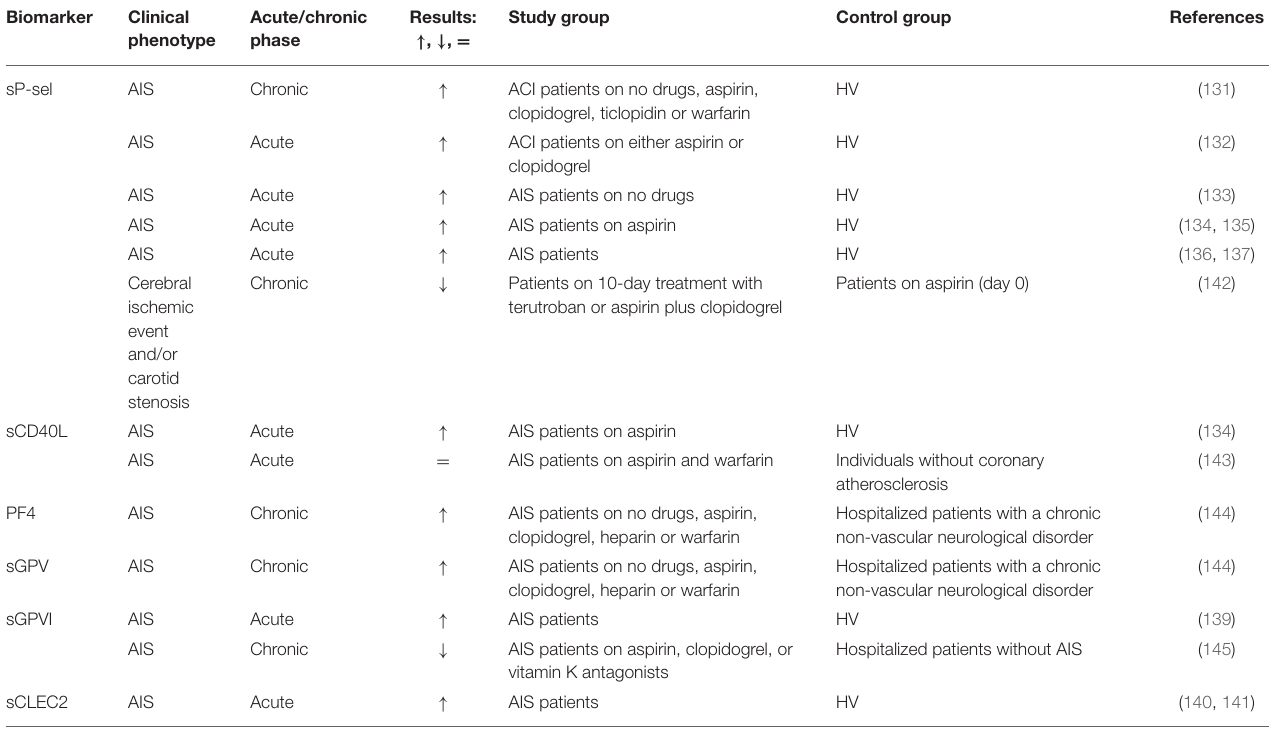
TABLE 4 | Soluble biomarkers of platelet activation in acute ischemic stroke (AIS)